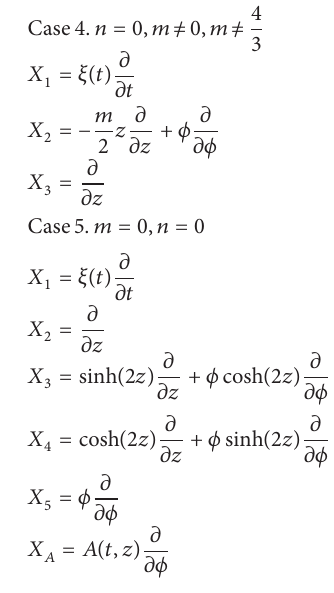
Table 2: Lie point symmetries of the partial differential equation